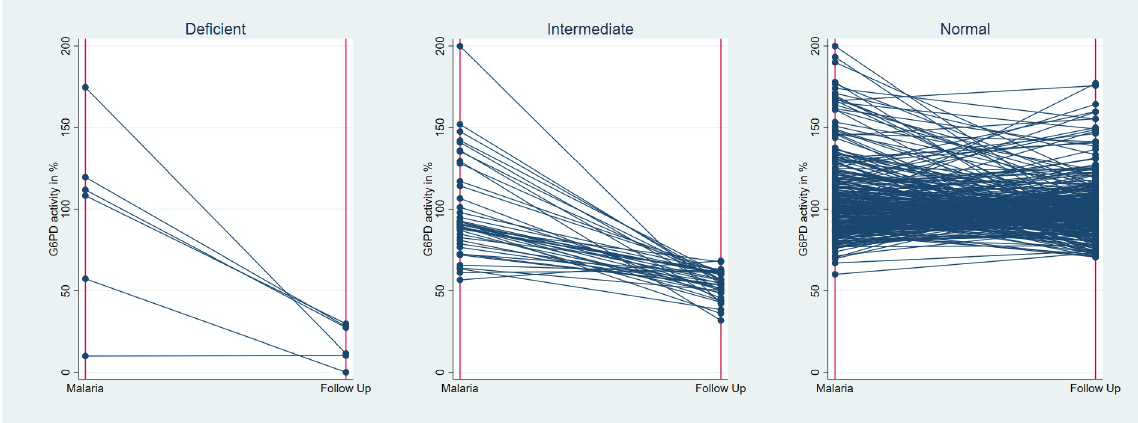
Fig 1. Change in G6PD activity between the malaria episode and follow up, stratified by G6PD status at the time of follow up.